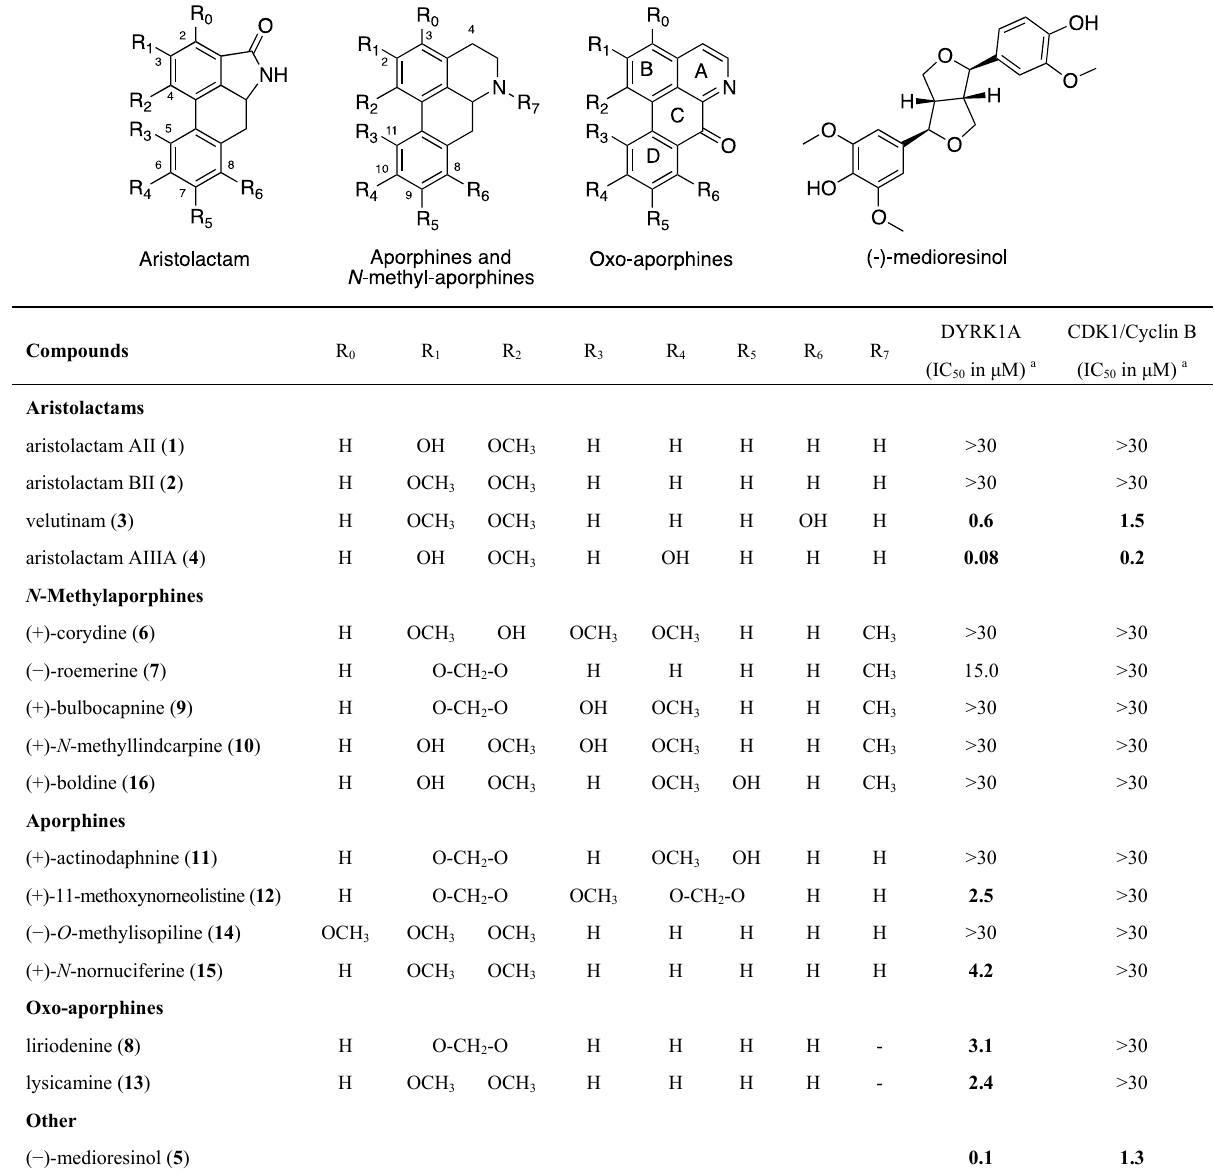
Table 1. Biological activities of the compounds isolated from the Annonaceae and Monimiaceae plant families.